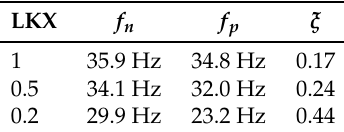
Table 5. Values of the peak frequency f p , undamped natural frequency f n , and damping ratio ξ of the first mode of the tyre for different longitudinal slip stiffness scaling factors LKX,